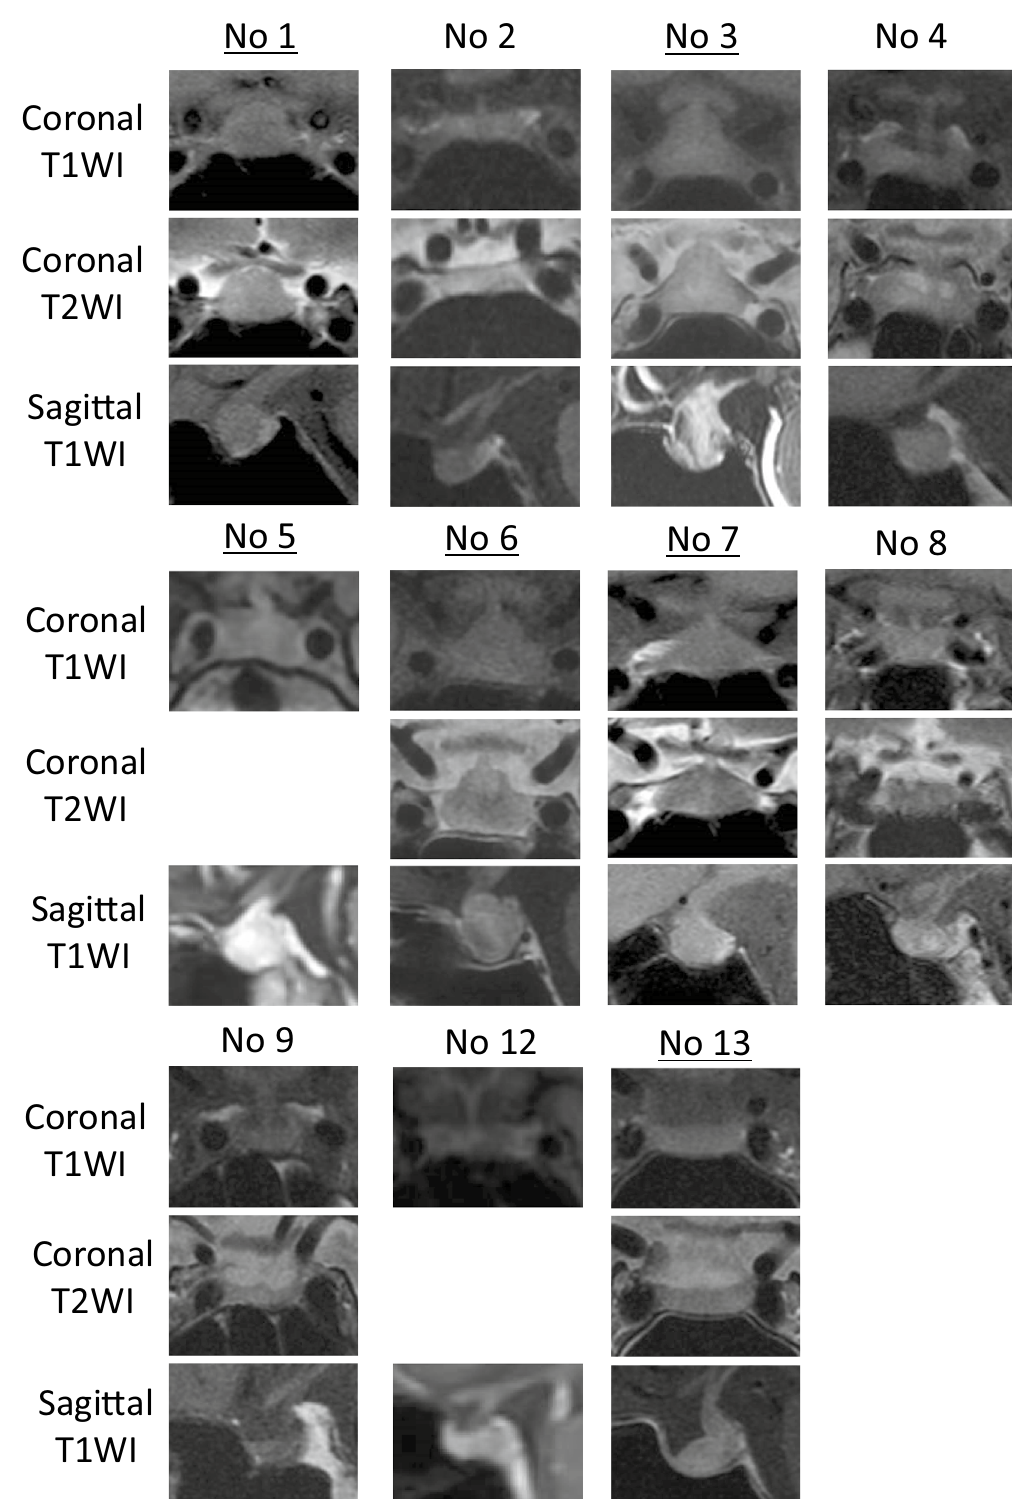
Figure 2. Pituitary MRI of the patients with secondary adrenal insufficiency. MRI analysis revealed enlargement of the pituitary gland in patients No 1, 3, 5–7, and 13 (highlight with underline). Top panels are coronal non-enhanced T1WI, middle panels are coronal T2WI (patents No 5 and 12 lack coronal T2WI), and bottom panels are sagittal enhanced T1 (if not available, non-enhanced T1WI) for each